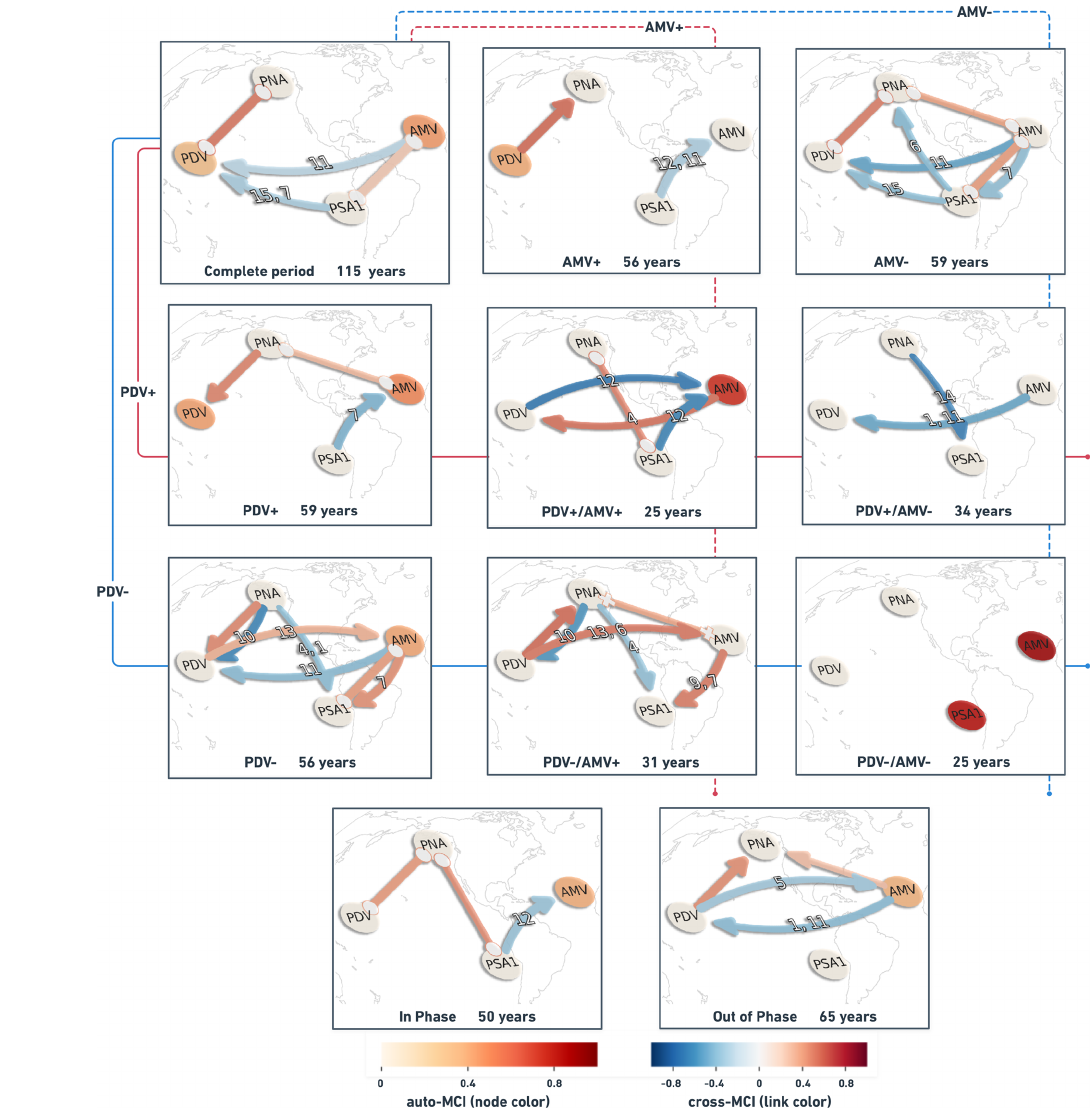
Figure 5. Causal networks calculated with PCMCI + from reanalysis data for the complete 1900–2014 period (upper left panel) and the different regimes. Nodes represent the time series associated with each climate variability index (see node labels) masked according to the predefined regimes. Node colors indicate the level of autocorrelation (auto-MCI) as the self-links of each node, with darker red indicating stronger autocorrelations (color bar, lower left), while the color of the arrows (termed “links” here) denotes the inter-dependency strength (cross-MCI), with blue indicating opposite-sign (or negative) inter-dependency and red indicating same-sign (or positive) inter-dependency strength (color bar, lower right). Small labels on the curved links indicate the link-associated time lags (unit = 1 year). Straight links show contemporaneous inter-dependencies that happen with no time lag (i.e., τ < 1). Each network is sub-labeled with its respective regime name and the total number of unmasked years (time steps) that characterize that regime (label and number of years at the bottom of each panel). Lines going through the panels are to help visualize which combinations make up the regimes. Solid lines are for PDV, and dashed lines are for AMV. Red is for warm ( + ) phases, and blue is for cold ( − ) phases (e.g., PDV + /AMV − regime panel has a solid red line and a dashed blue line going through